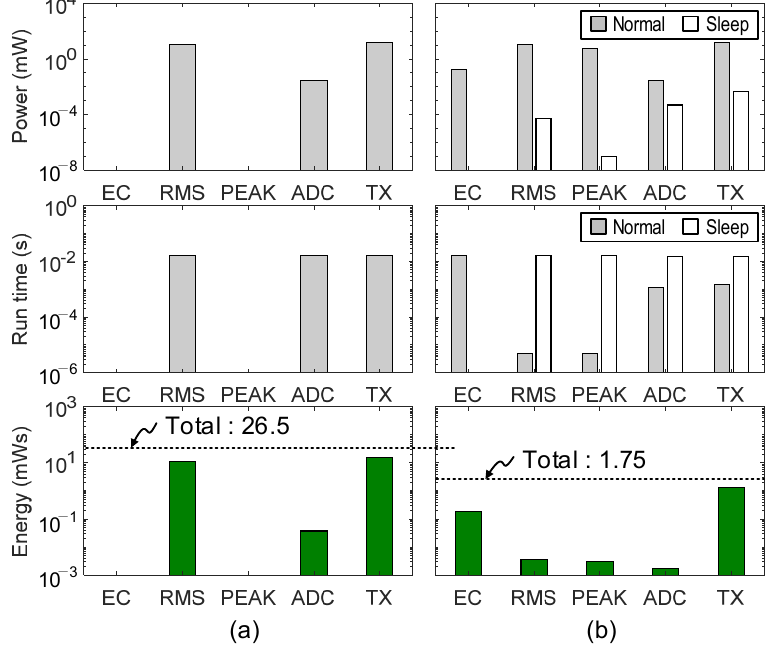
Figure 16. Measured power and energy consumption in each block for ( a ) conventional monitoring system without an EC and ( b ) proposed event-driven monitoring system.